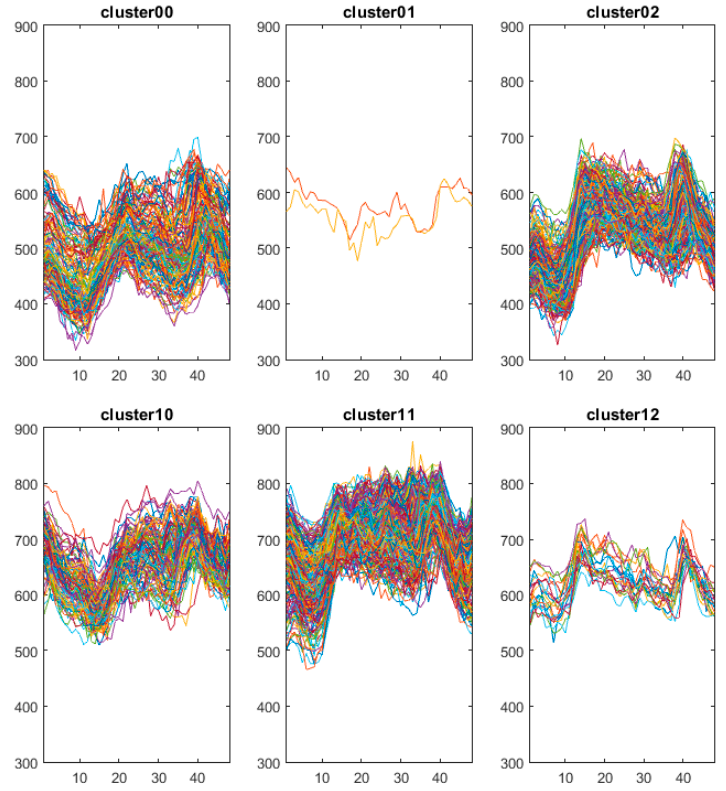
Figure 7. Original Pearson results.